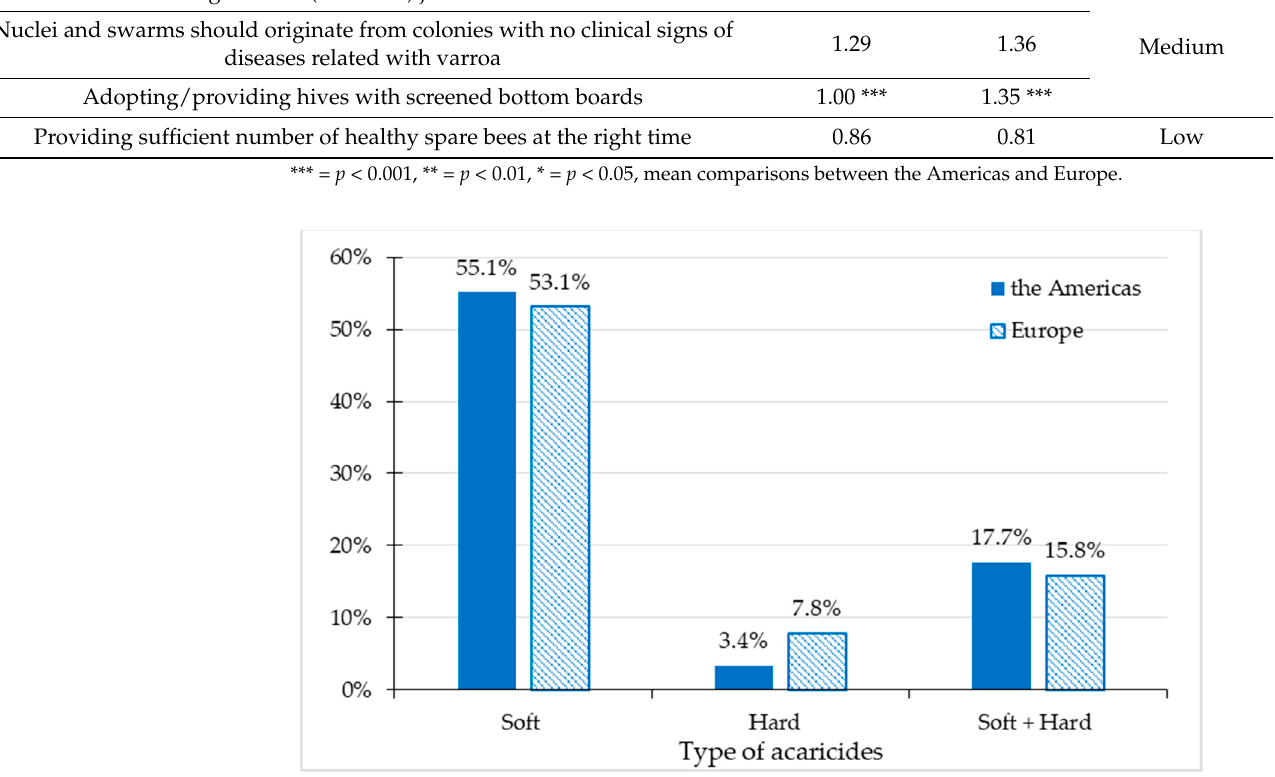
Figure 3. Active ingredients, grouped as “Hard” and “Soft” acaricides, used by American and European beekeepers. With regard to the number of annually applied treatments for varroa control, a plurality of European (45.2%) and American beekeepers (49.7%) used more than one